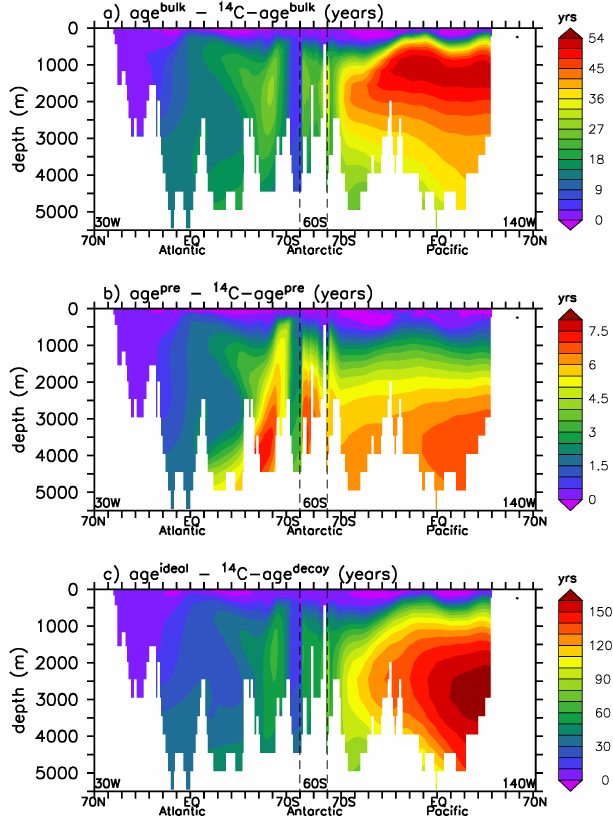
Figure 5. Anomalies (ideally behaving tracer − 14 C-based tracer) of bulk age (a) , preformed component of age (b) and circulation component of age (c)